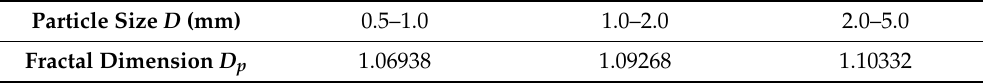
Figure 12. lg P –lg A fitting curve of coral sand with different particle sizes: ( a ) D = 0.5–1.0 mm, ( b ) D = 1.0–2.0 mm, and ( c ) D = 2.0–5.0 mm. Table 3. Fractal dimension of coral sand with different particle sizes.